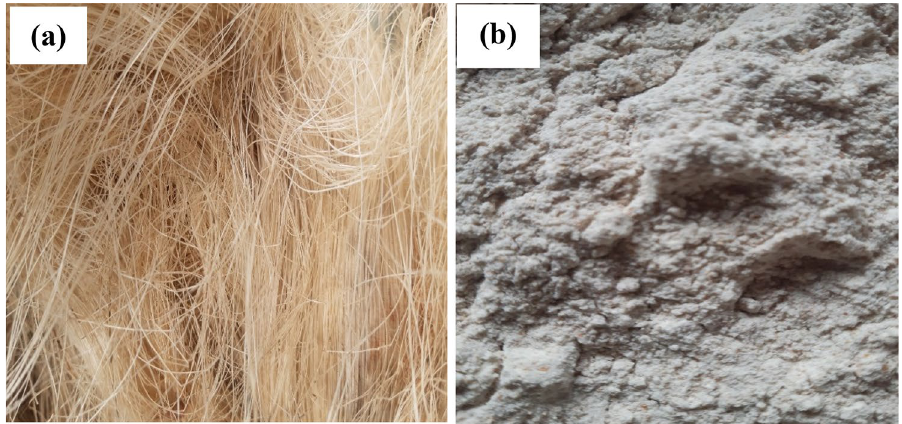
Figure 1. Image of input materials ( a ) kenaf fiber ( b ) Particulate snail shell.